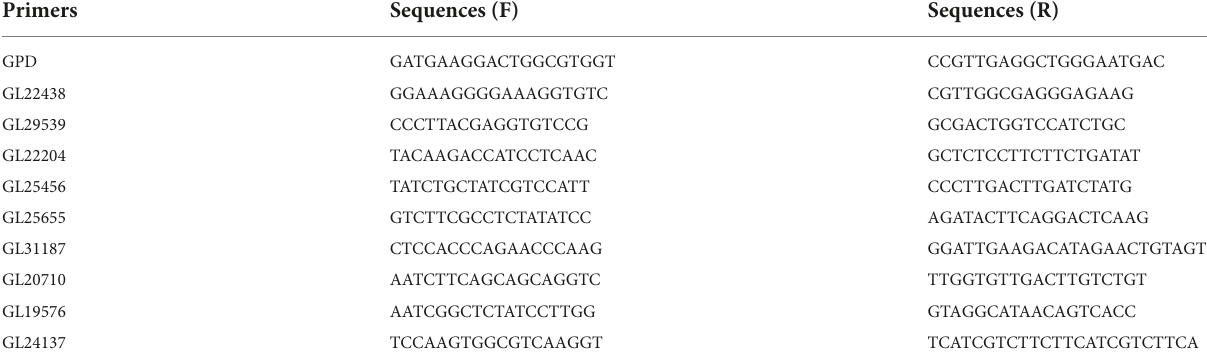
TABLE 1 Primer sequences used for qRT-PCR